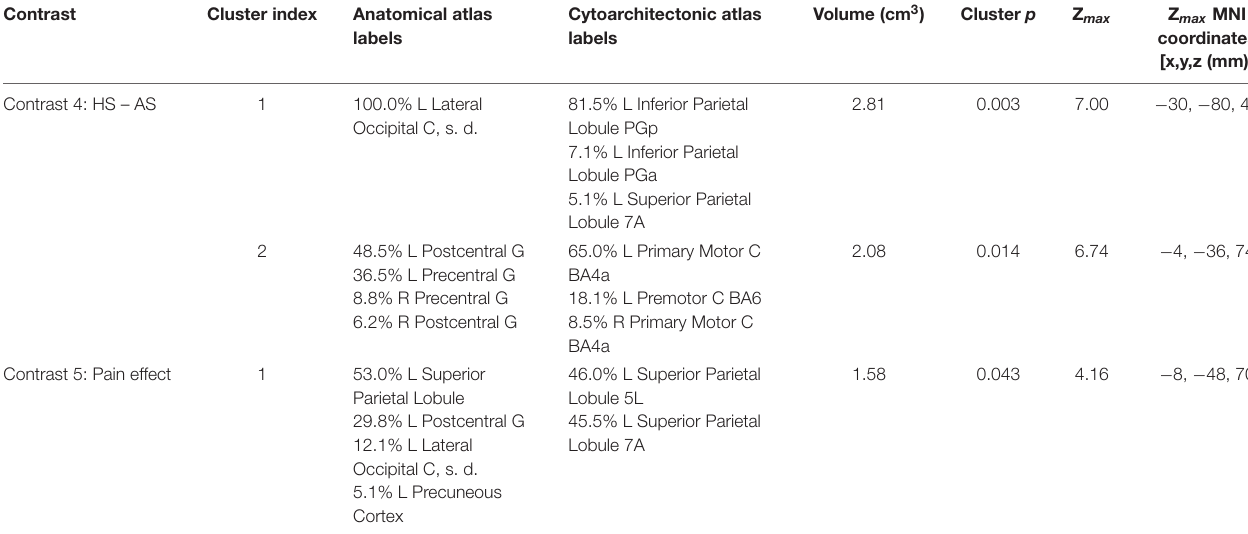
Table lists significant F-test clusters in Contrast 4 (HS – AS), i.e., the differences between heel and ankle stimulation, and in Contrast 5 (Pain), i.e., the pain effect. Anatomical and cytoarchitectonic labels are provided including the proportion of labeled voxels. Only labels consisting at least 5% of activated voxels are shown. Note that cerebellar labels may overlap with cortical labels and that cytoarchitectonic labels do not cover the whole brain. Abbreviations: C, cortex; BA, Brodmann area; G, gyrus; MNI, Montréal Neurological Institute; R, right; s. d., superior division; Zmax, maximum Z score.